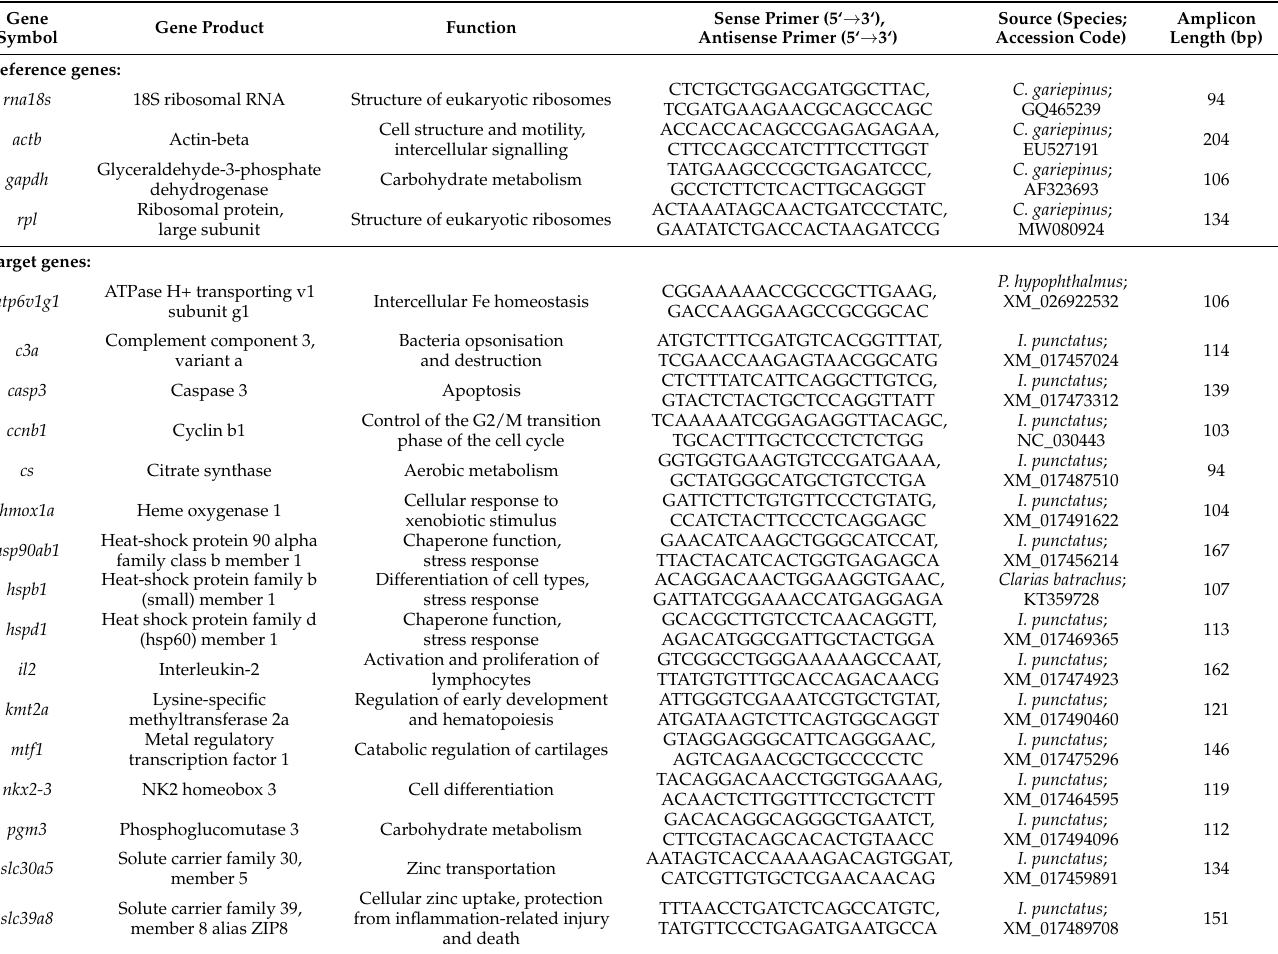
Table A1. Oligonucleotide-primer sequences derived from Clarias gariepinus, Ictalurus punctatus, or Pangasianodon